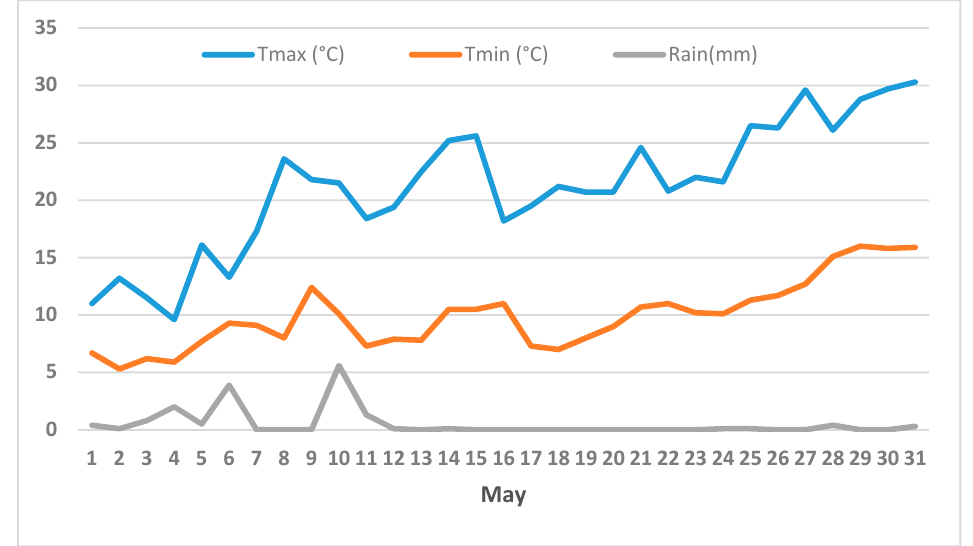
Figure 2. Minimum (Tmin), maximum (Tmax), and rain fall in May 2018 at NIBIO Ullensvang, (Norwegian Institute of Bioeconomy Research), Norway.